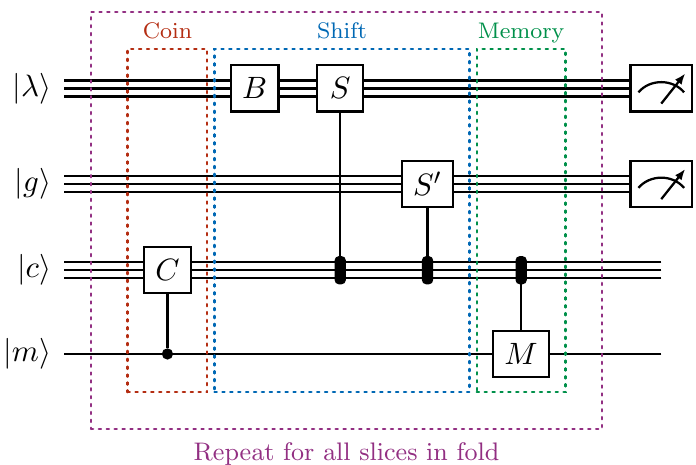
Figure 3. Schematic of the quantum Discrete QCD parton shower algorithm circuit. The algo- Figure 1: Schematic of the quantum circuit for one slice in the fold. For each slice, the algorithm is split rithm is a quantum walk with memory, constructed from maximum five operations per step: the into three distinct sections: (1) The coin operation, C , controls from the relevant walk memory to apply coin operation C , baseline shift B , the λ shift S , the gluon shift S 0 , and the memory operation M the correct coin operation to the coin register; (2) the shift operation first increases the walker’s position along the base of the fold, B , and then controls from the coin outcome to shift the walker accordingly to increase the grove baseline, S , and e ↵ ective gluon position, S ; (3) The memory operation, M , then 0 updates the memory register with the outcome of the coin operation. This is then repeated for all slices in the primary fold, and any subsequent folds formed.